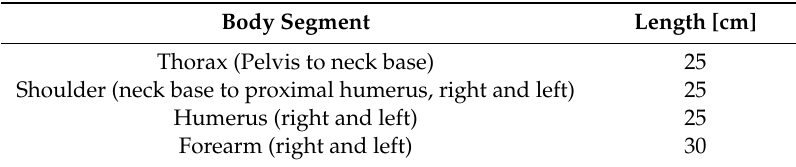
Table 1. Avatar body segment lengths in centimeters.